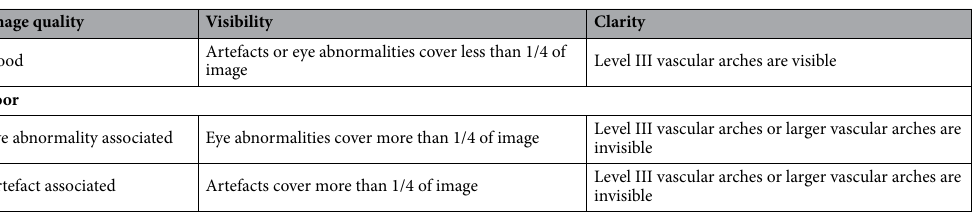
Table 3. Definition of image quality